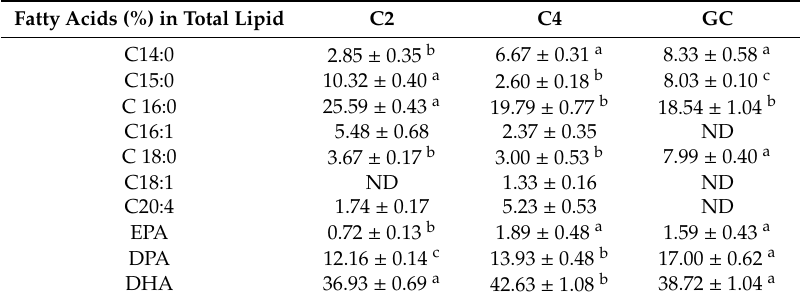
Table 3. Fatty acid composition (wt% of total fatty acids) of Aurantiochytrium sp. T66 cultivated on